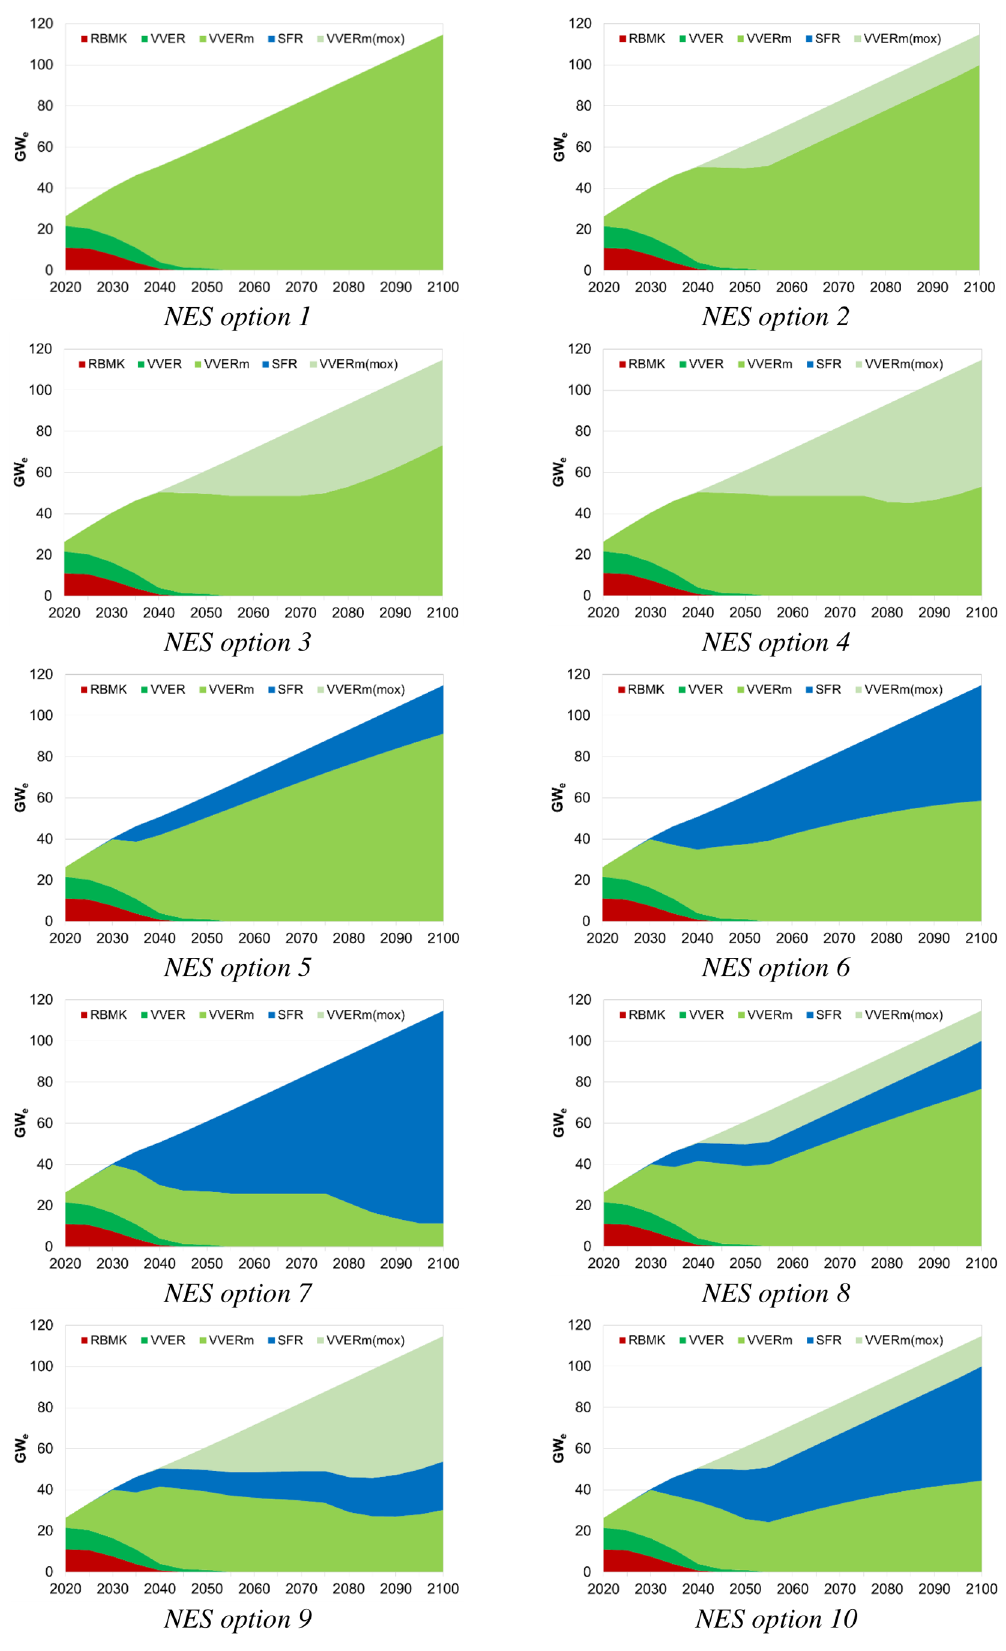
Fig. 2. NES con fi gurations under